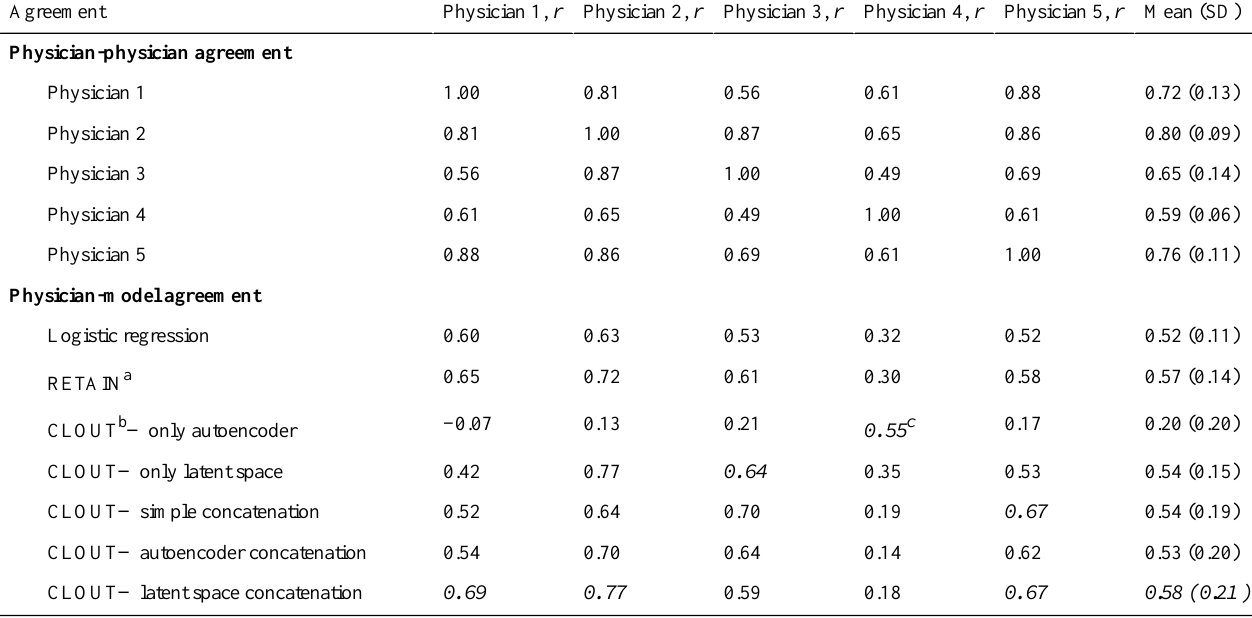
Table 4. Pearson correlation coefficients for agreement between physicians and